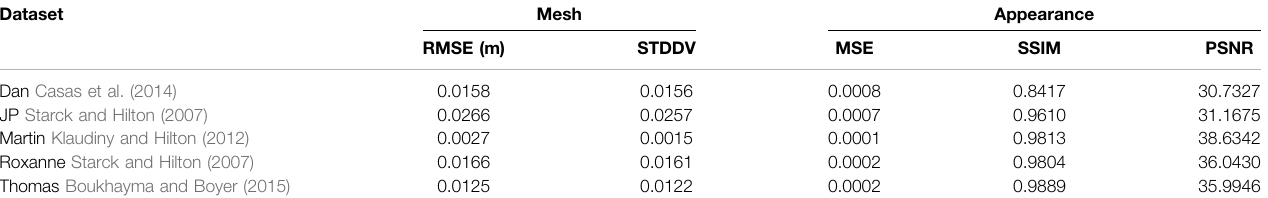
TABLE1| Comparisonoferrormetricsusedforevaluationof3Dmeshand2Dtextureappearance.Thevaluesrepresenttheaverageerroracrosstheallmotionsequencefor different datasets. Dataset